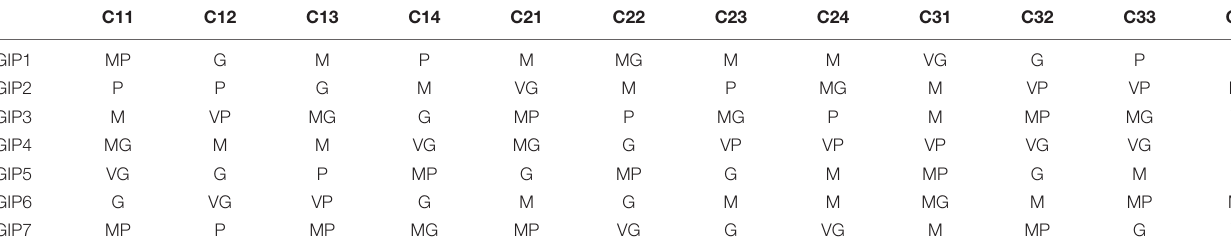
FIGURE 3 | The internal and external forces of DGI partners. TABLE 2 | The evaluation matrix of academic institutions provided by DGI experts.